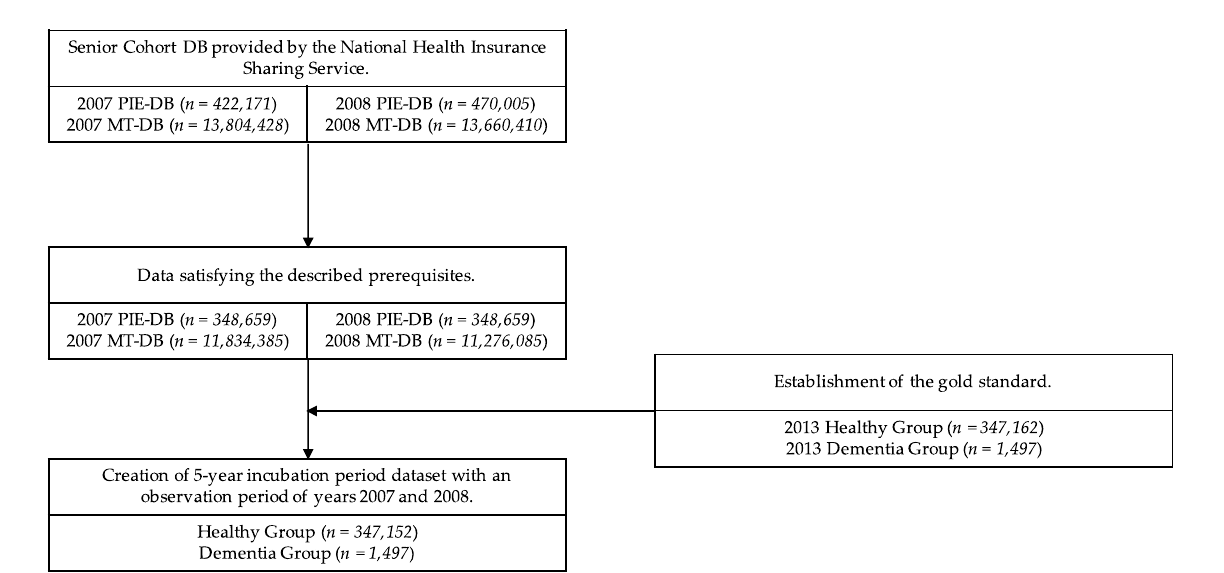
Figure 1. Flowchart of the study population. Abbreviations: PIE-DB: Participant Insurance Eligibility Database; MT-DB: Medical Treatment Database. Table 1. Dementia classification